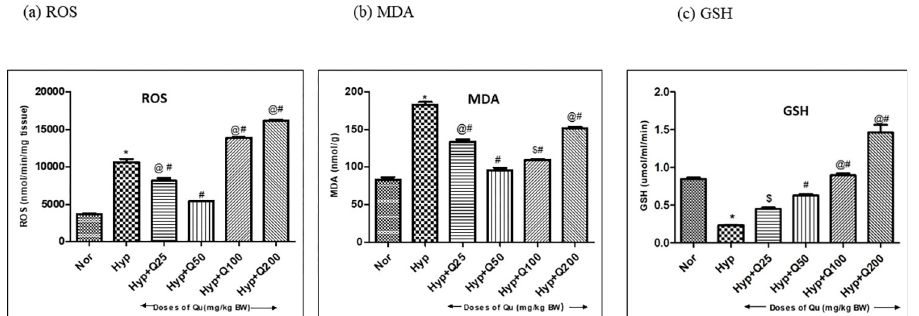
Fig 6. Effect of different doses of quercetin (25mg, 50mg, 100mg and 200mg/Kg BW) on (a) Reactive Oxygen Species (ROS) (b) Malondialdehyde (MDA) and (c) Reduced Glutathione (GSH) levels in kidneys of rats exposed to hypobaric hypoxia at 7,620m for 12h at 25 ± 2˚C. Values are mean ± SD (n = 6). (a) ROS: � p < 0.001 Norm v/s Hypo (12h); #p < 0.001 Hypo v/s Hypo+ Q25mg, Hypo + Q50mg, Hypo+ Q100mg, Hypo+Q200mg; @p < 0.001